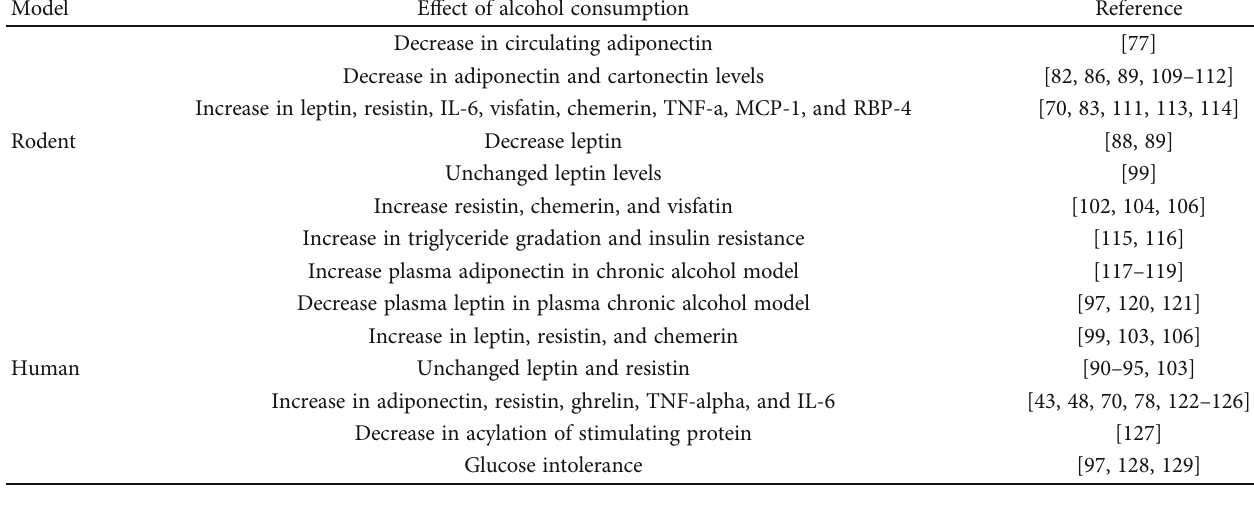
Table 1: Adipokine response to consumption of alcohol in rodents and humans.